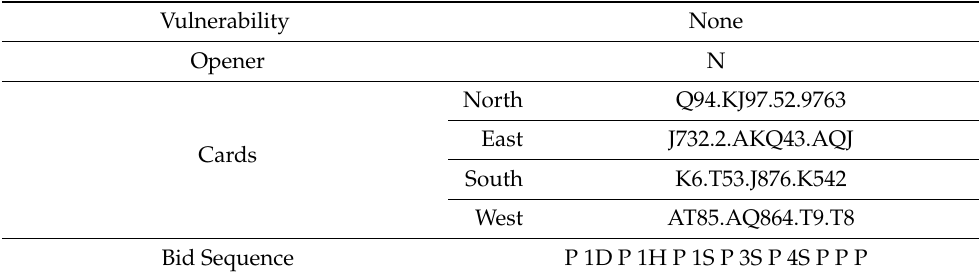
Table 2. An example of training data in BM.